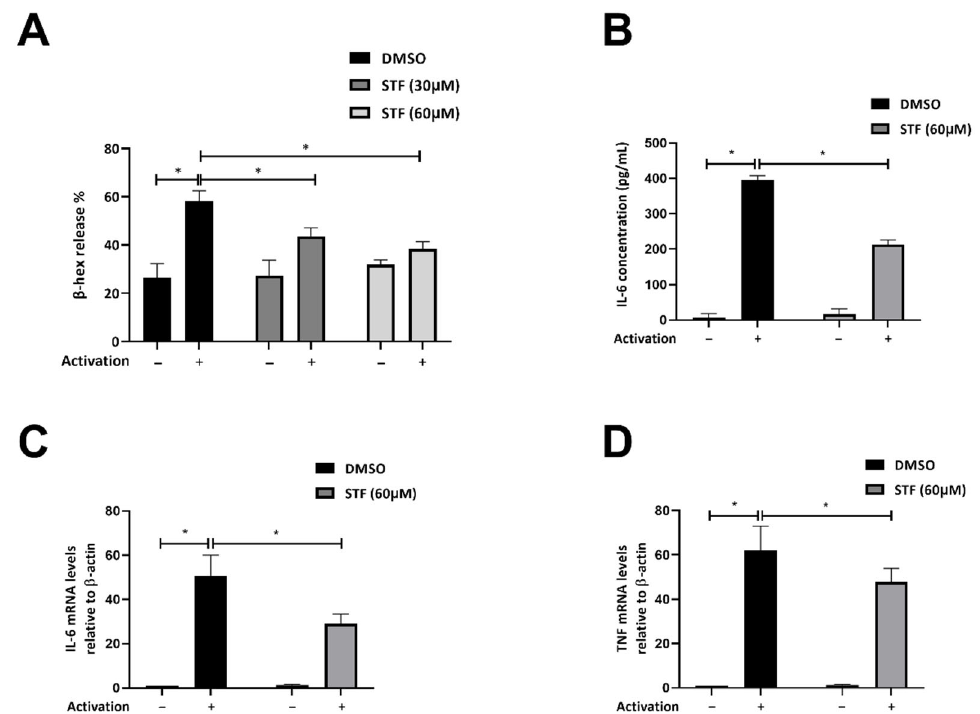
Figure 2. Inhibition of IRE1 nuclease activity decreases the secretory response to IgE-mediated CBMC activation. Sensitized CBMCs were pretreated with DMSO or STF (30 or 60 µ M) 1 h prior to activation with rabbit anti-human IgE Ab (5 µ g/mL). Thirty minutes after activation, ( A ) supernatants and cell pellets underwent chromogenic assay for β -hex quantification. Data are shown as mean ± SD. * p < 0.05. ( B ) Supernatants were collected following 4 h of activation and analyzed for IL-6 by ELISA. Each bar represents the average of three independent measurements ± SD. * p < 0.05. ( C ) RT-qPCR analysis of IL-6, and ( D ) TNF following 4 h of activation. The average of mRNA levels normalized to β -actin ± SD of three independent experiments is shown. * p <